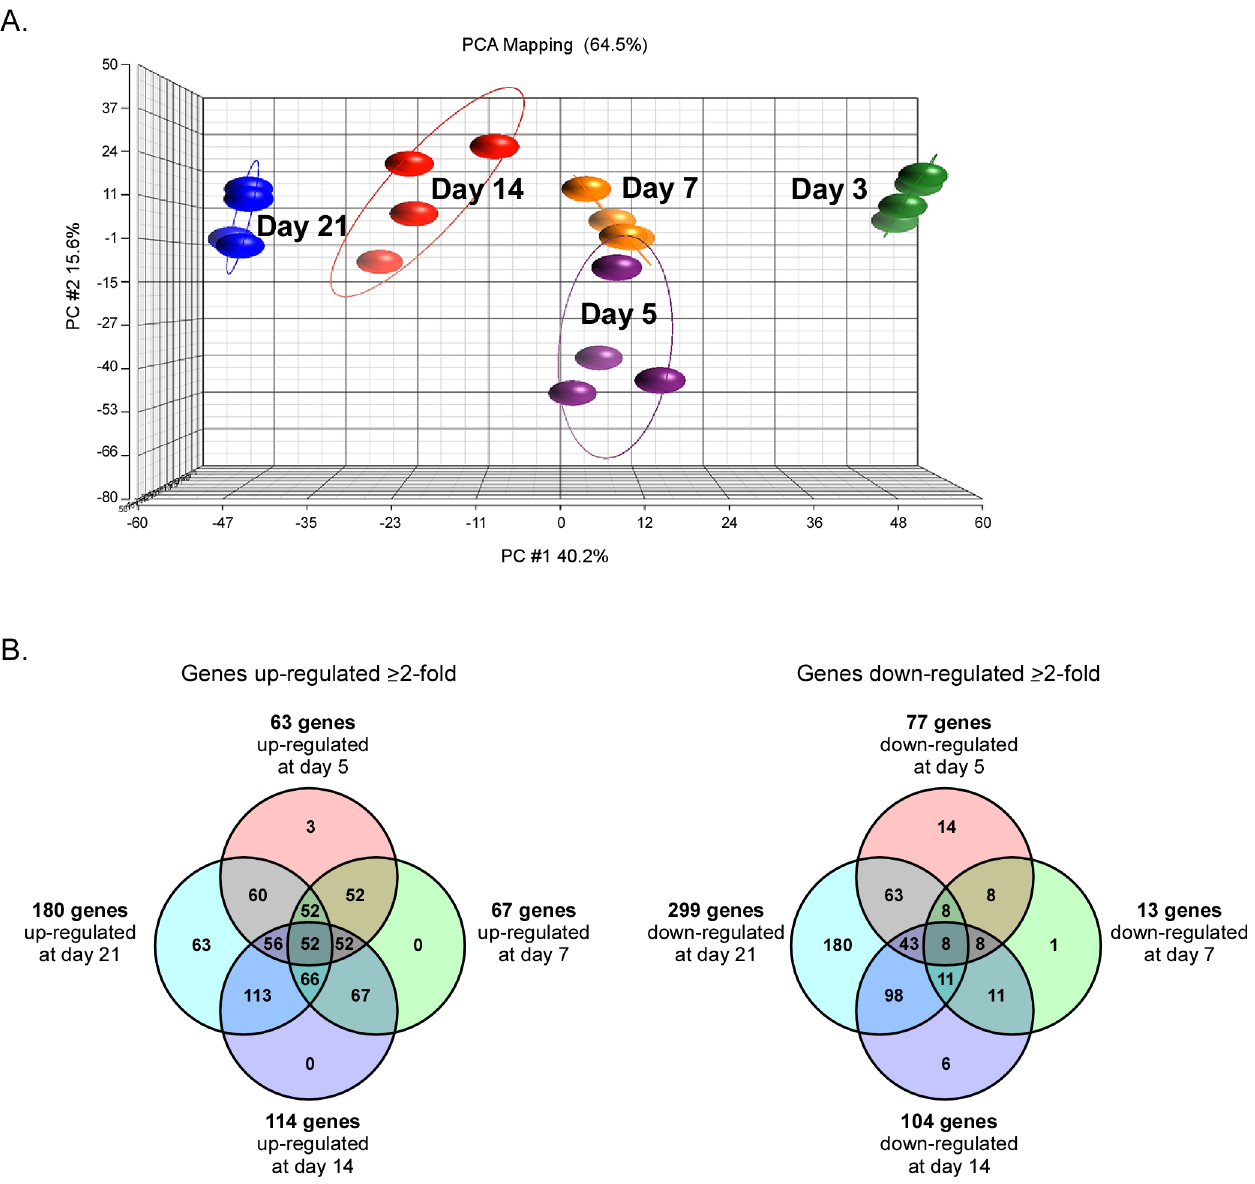
Fig 2. Transcriptional profiling of C . burnetii LCV to SCV morphological transition during intracellular growth in Vero cells. (A) Principal-component analysis showing distinct grouping of microarray expression data at each time point (4 biological replicate samples). (B) Venn diagrams showing the number of genes up or downregulated (cid:1) 2 fold at 5, 7, 14, and 21 days post-infection of Vero cells relative to 3 days